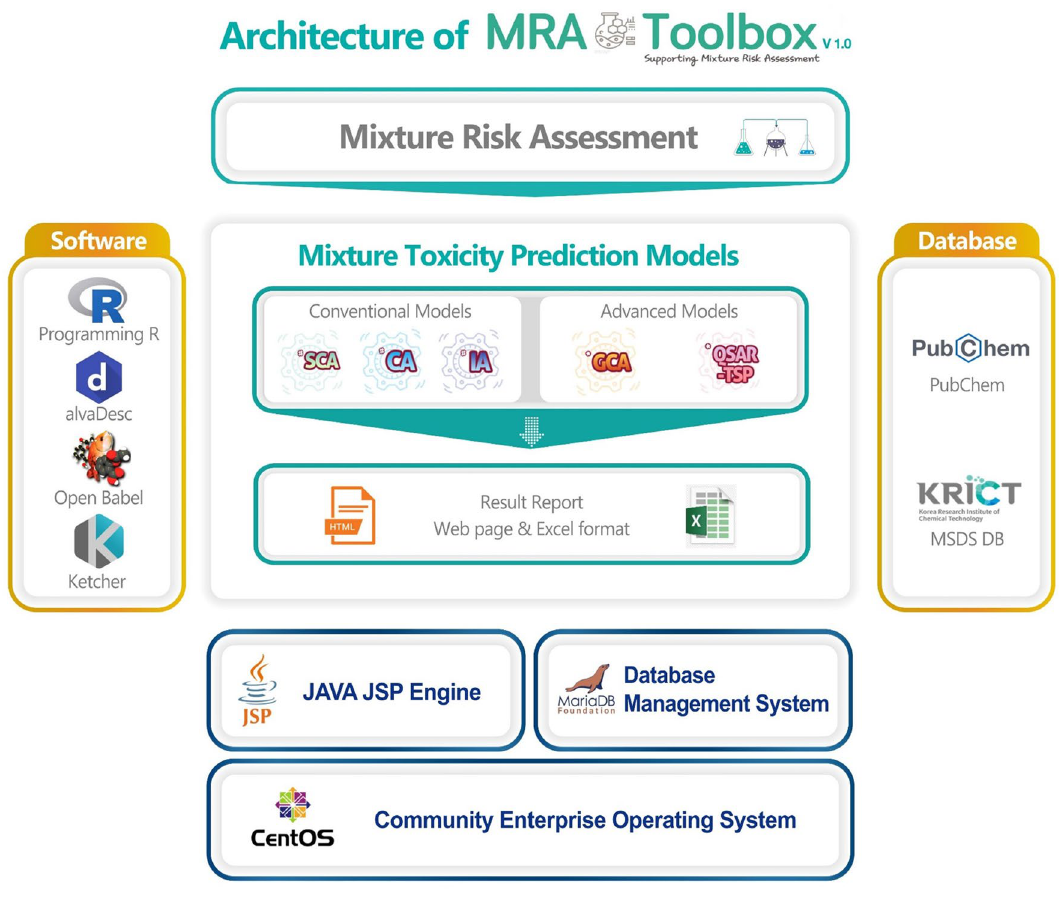
Figure 1. Architecture of MRA Toolbox v.